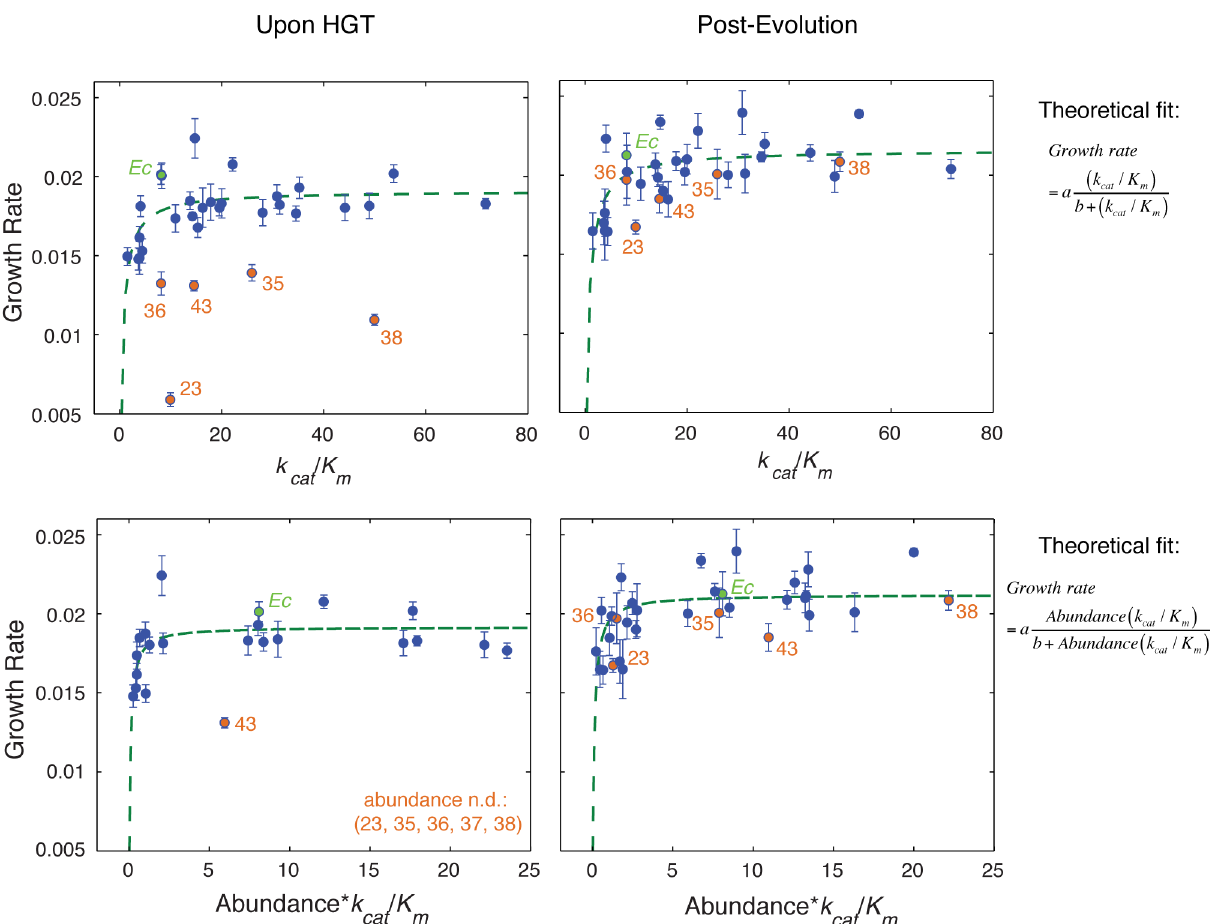
Fig 3. Fitness landscape of HGT strains is largely explained by flux dynamics theory. A) Relationship between activity ( k cat / K m ) of the purified orthologous DHFR proteins and growth rate of the naive HGT strains (prior to evolution experiment). Strains that exhibit the most dramatic drop in fitness (DHFR-23, 35, 36, 38, and 43) are highlighted in orange (see Fig 1C). Wild type E . coli is labeled Ec . No correlation between fitness and activity exists (R = 0.34, p-value = 10 − 1 ) when all points are included (see Fig 4A). However, after excluding the outliers (DHFR-23, 35, 36, 38, and 43), the relationship between activity and growth follows flux dynamics theory that predicts that growth rate is proportional to total folate turnover (see the equation on the right; constants a and b depend on the number of enzymes and topology of the metabolic network) (green line, p-value = 10 − 4 ). B) Growth rate and activity after the evolution experiment. Similar to (A), fit also excludes DHFR-23, 35, 36, 38, and 43, but they nonetheless migrate to the prediction of the flux dynamics theory (n.d. – non-detectable). C-D) Relationship between growth rate and the product of relative intracellular abundance (from total lysates) and activity ( k cat / K m ). Theoretical fit also excludes DHFR-23, 35, 36, 38, and 43. (p-values are < 10 − 4 for all theoretical fits in panels